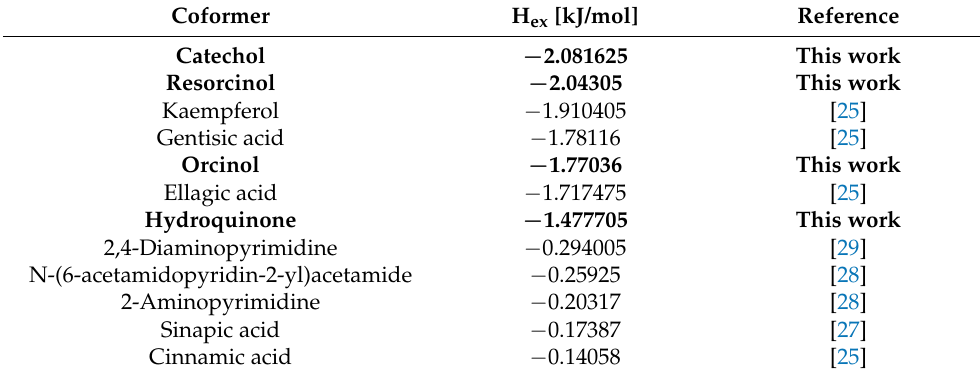
Table 1. Ranking positions for coformers reported at CSD that form multicomponent solids with PTU, including the coformers used in this study (in bold) based on COSMOQuick calculations. Coformer H ex [kJ/mol]